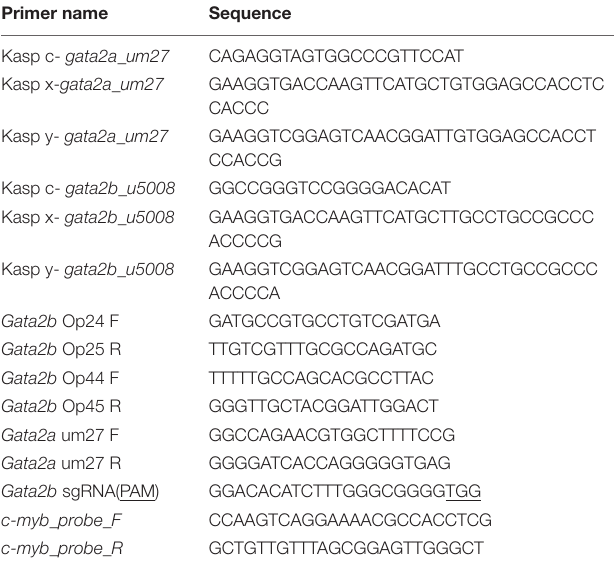
TABLE 1 | Primers and guide